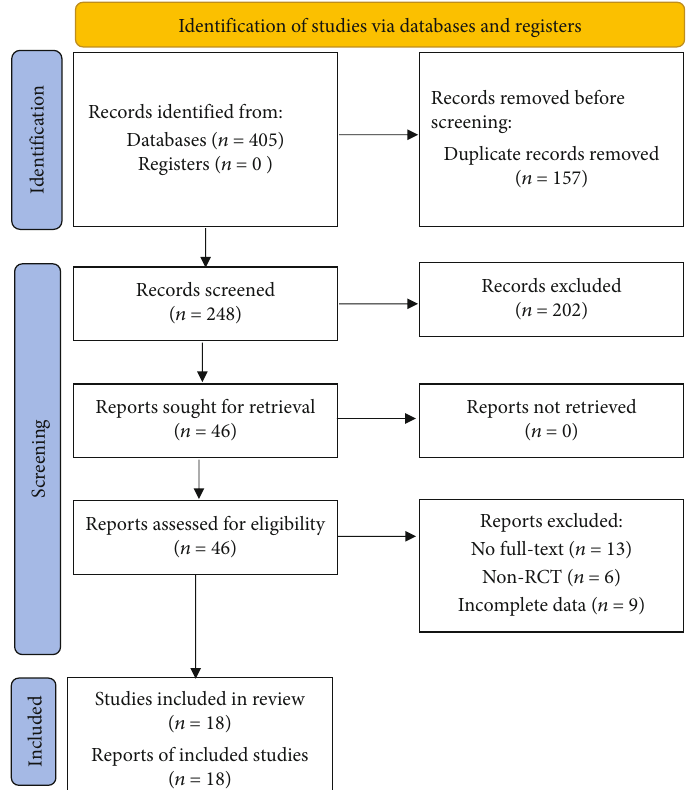
Figure 1: Screening process of literature